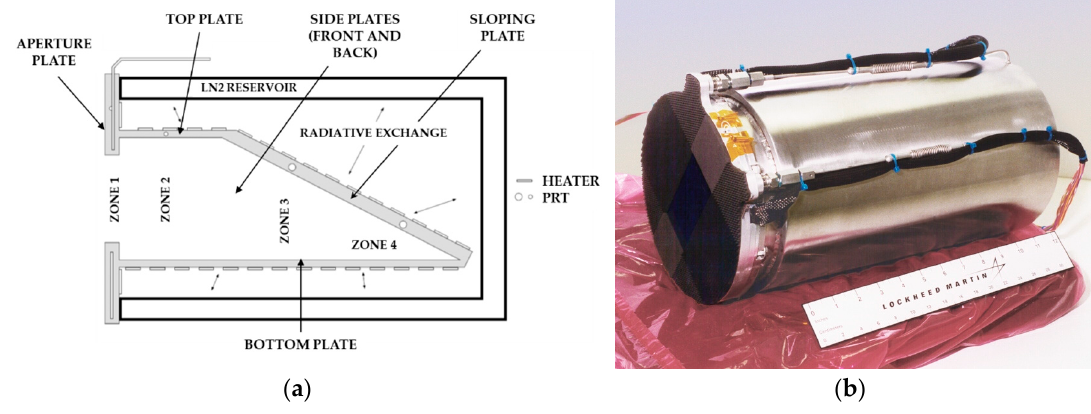
Figure 4. Large area blackbody (LABB) cavity cross-section ( a ) and completed assembly ( b ).